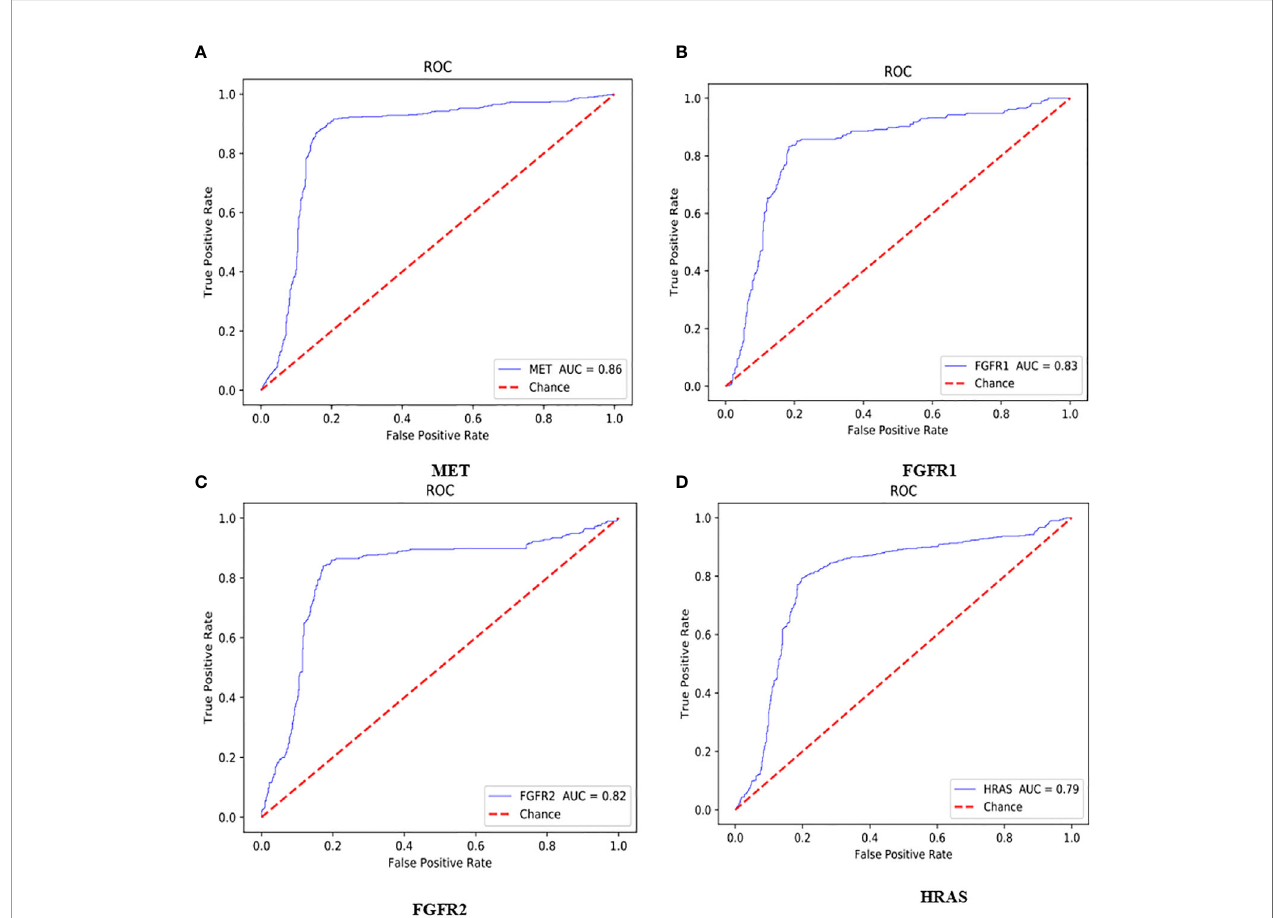
FIGURE 5 | ROC curve with 512*512 image blocks by 2 times cross-validation, sub fi gures of (A – D) was the ROC curve of mutated gene MET, FGFR1, FGFR2, HRAS